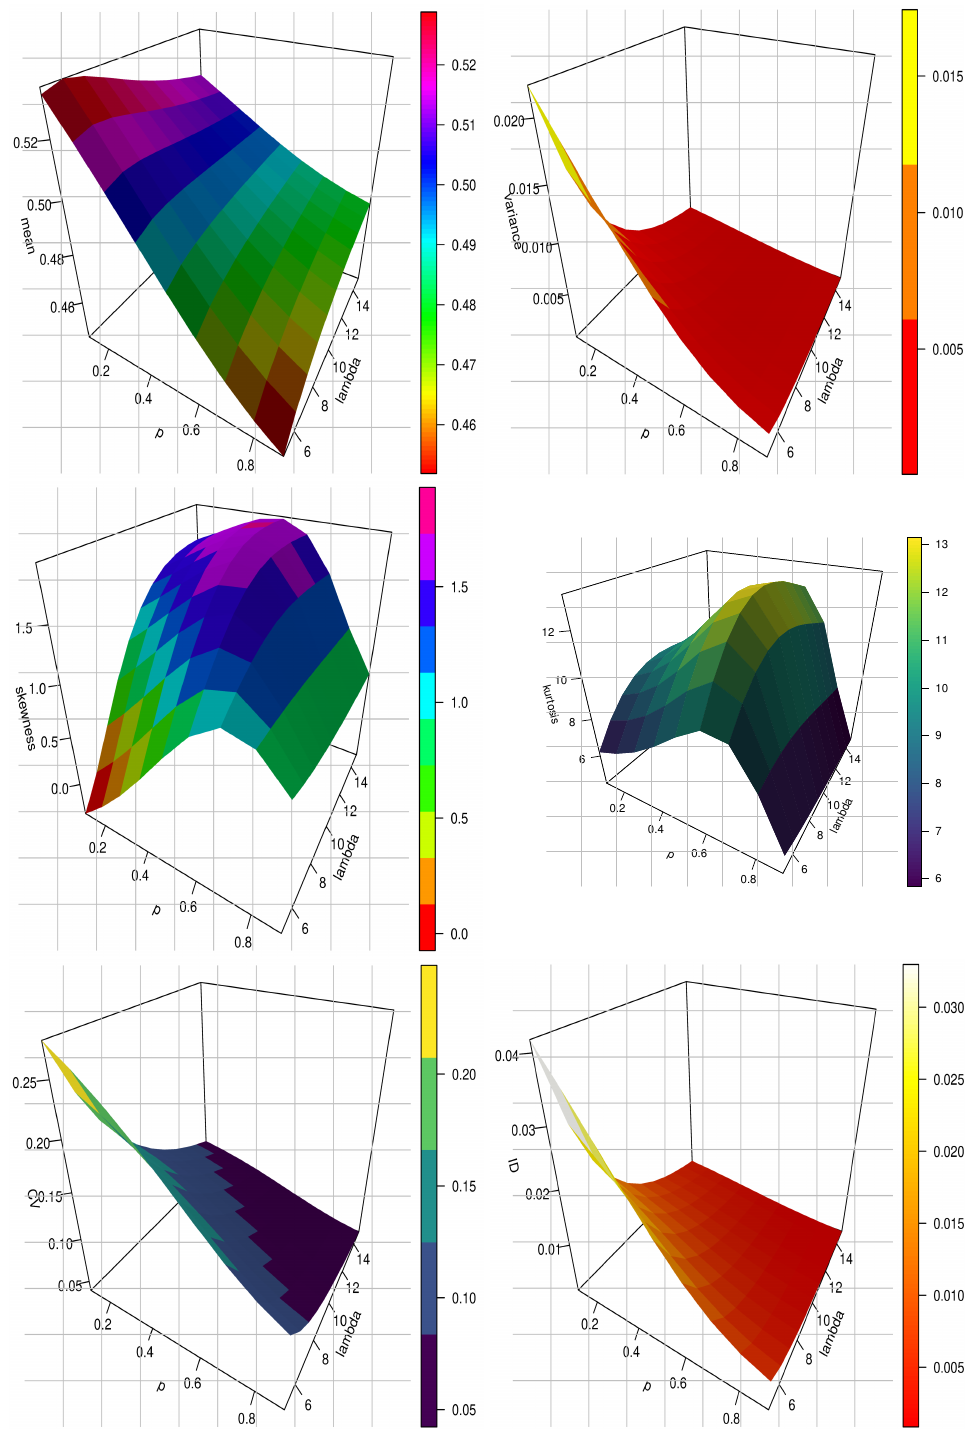
Figure 9. 3D plots of mean, variance, CS, CK, CV and ID for FB Model at p ∈ [ 0,1 ] , λ ∈ [ 5,15 ] and n =